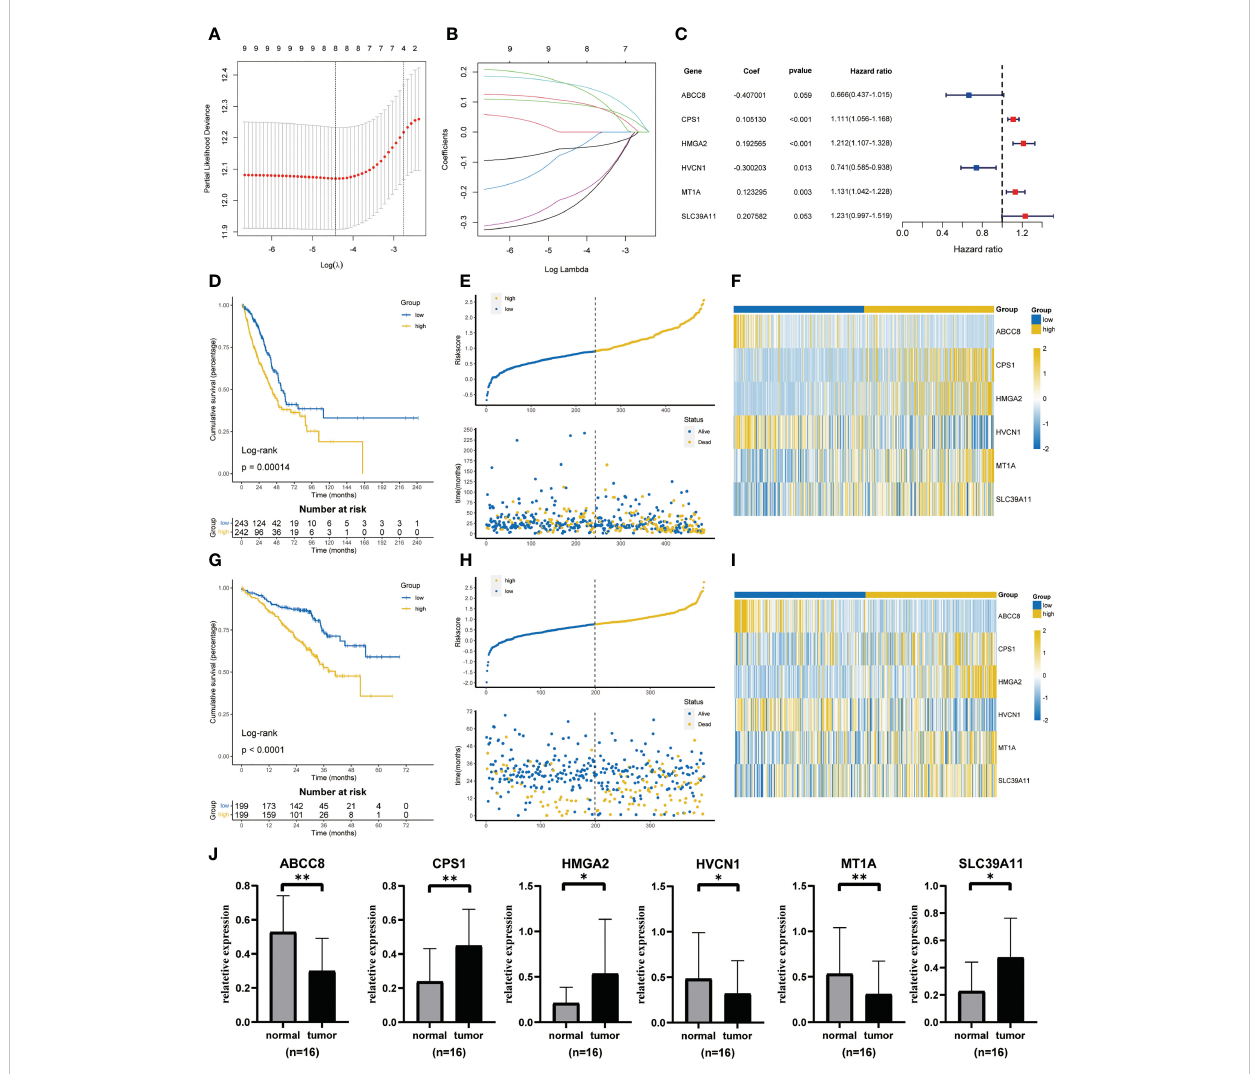
FIGURE 3 Construction and validation of ZMRGS. (A) Tenfold cross-validation in LASSO model. (B) LASSO coef fi cients of 9 prognostic-related genes. (C) 6 key zinc metabolism-related genes and their coef fi cients. (D) Kaplan-Meier survival analysis in TCGA cohort. (E) Distribution of risk score and OS status in TCGA cohort. (F) Heatmap of 6 zinc metabolism-related genes in TCGA cohort. (G) Kaplan-Meier survival analysis in GSE72094 . (H) Distribution of risk score and OS status in GSE72094. (I) Heatmap of 6 zinc metabolism-related genes in GSE72094. (J) The mRNA expressions of ABCC8, CPS1, HMGA2, HVCN1, MT1A and SLC39A11 by qRT-PCR. *p < 0.05, **p <